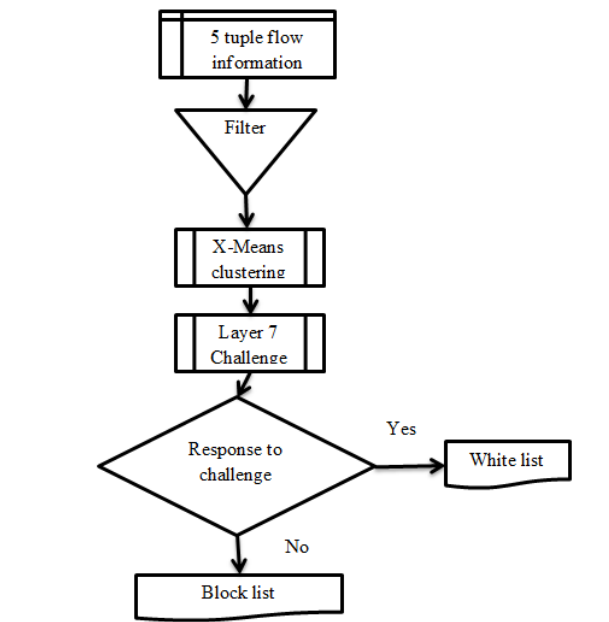
Figure 4. Mimicking detection algorithm at HTTP